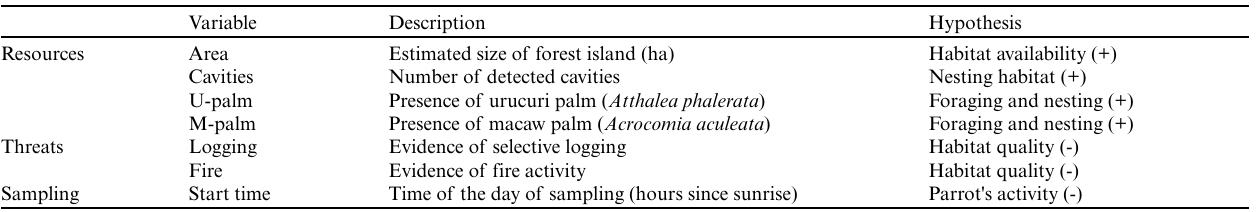
Table 1 . Variables and hypothesis proposed in the modeling of use of 60 forest islands of Beni savannas, Bolivia by 12 parrot species.